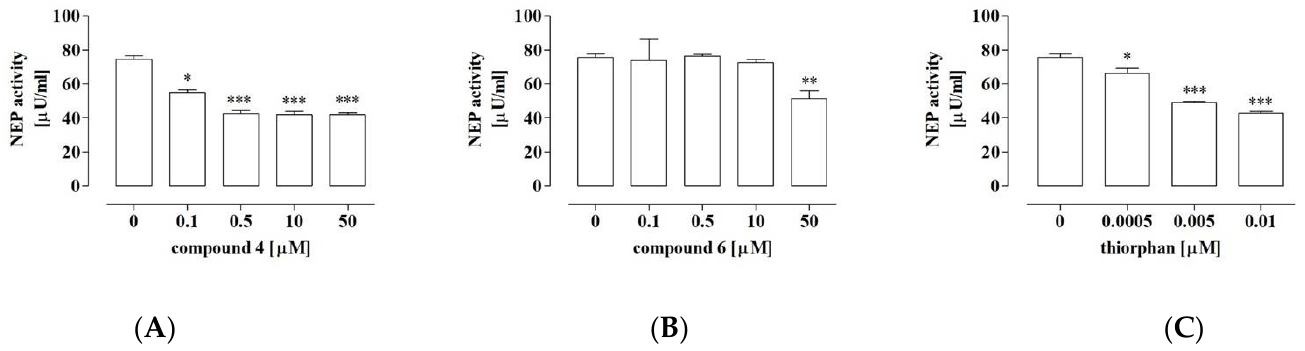
Figure 8. NEP activity in the presence of compound 4 ( A ), 6 ( B ), or the specific inhibitor of neutral endopeptidase—thiorphan ( C ). The NEP activity was determined with the fluorometric method. The results are mean values of activity ± SD of at least three independent experiments. Statistically significant differences: * p < 0.05, ** p < 0.01, and *** p < 0.001, in comparison with the control untreated cells (0 µM) (unpaired T-test).